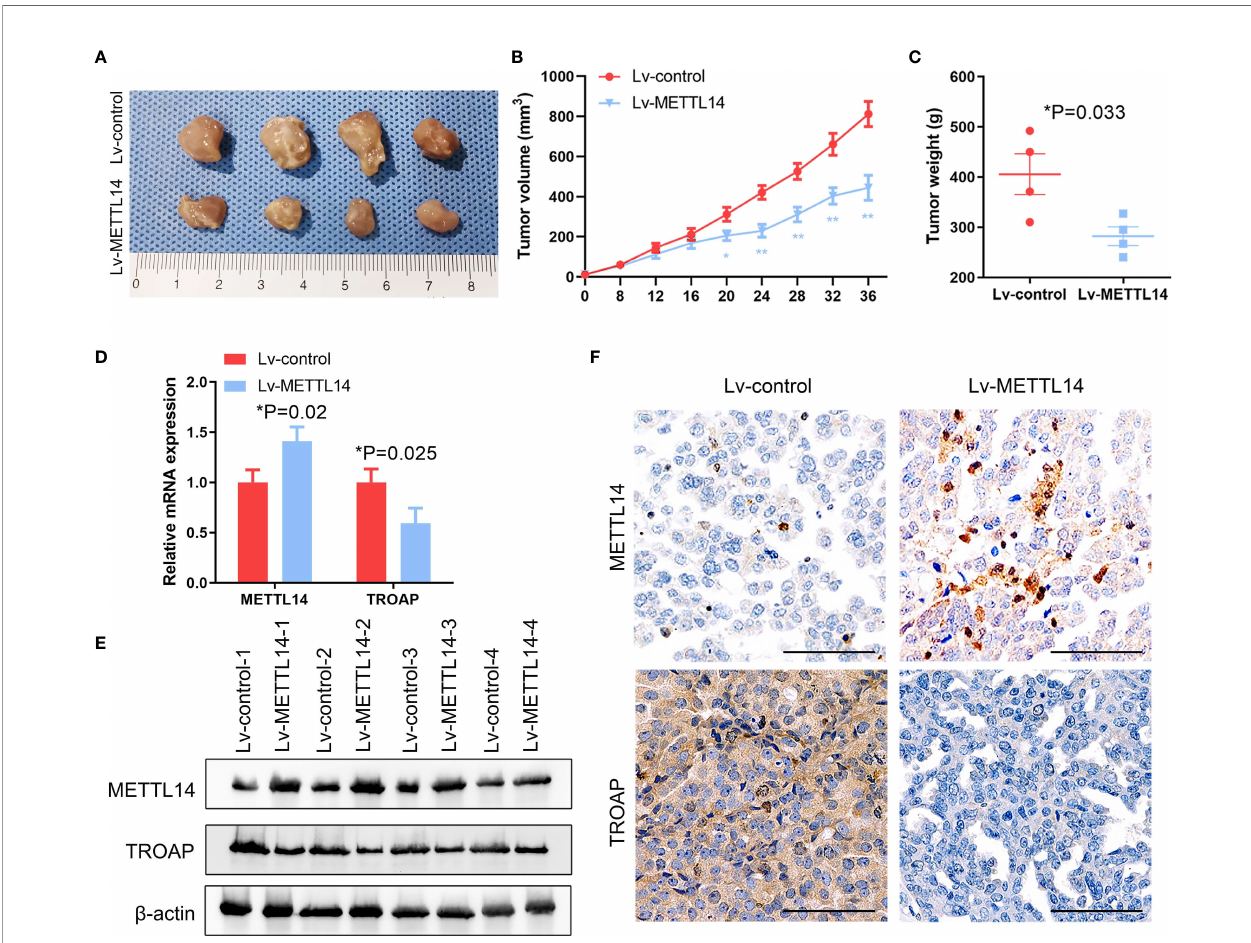
FIGURE 7 | METTL14 inhibits ovarian cancer growth in vivo . (A) Control or METTL14 – overexpressing lentivirus infected SKOV-3 cells were injected into nude mice, and tumor was evaluated after 36 days. (B, C) Tumor volume (B) and weight (C) at the end of the treatment period (**P < 0.01, *P < 0.05, *P = 0.033). (D, E) METTL14 and TROAP mRNA (D) and protein (E) expression levels assessed by real-time PCR and western blot analysis in tumors (*P = 0.02, *P = 0.025). (F) Xenograft tumor sections were subjected to IHC for METTL14 and TROAP. Magni fi cation, 600 ×. Data are shown as mean ± SD from three independent